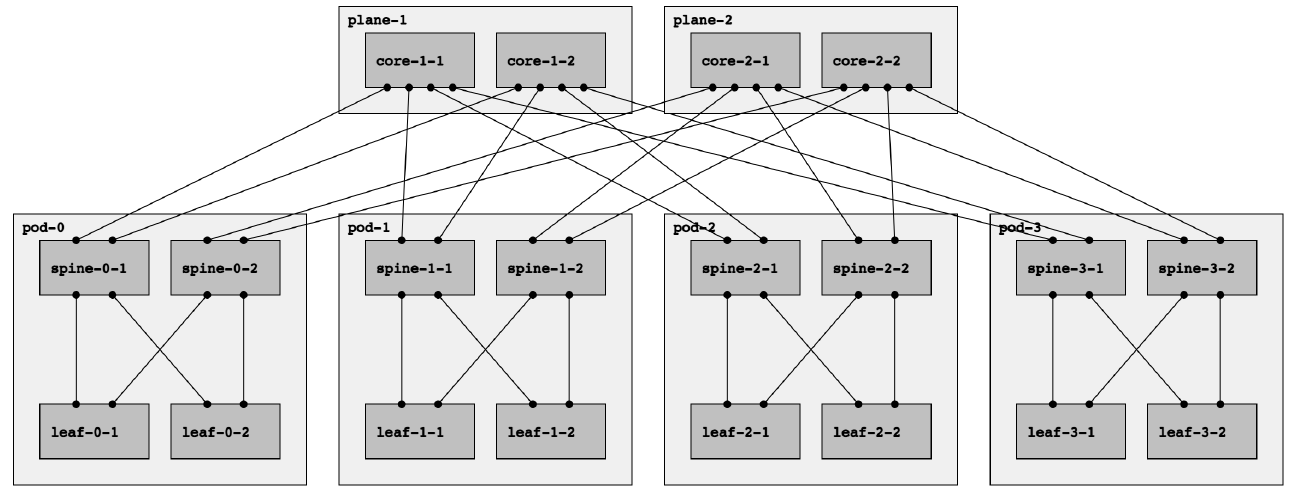
Figure 1. A fat-tree topology with k = 4: four-port switches arranged in four PoDs with four switches